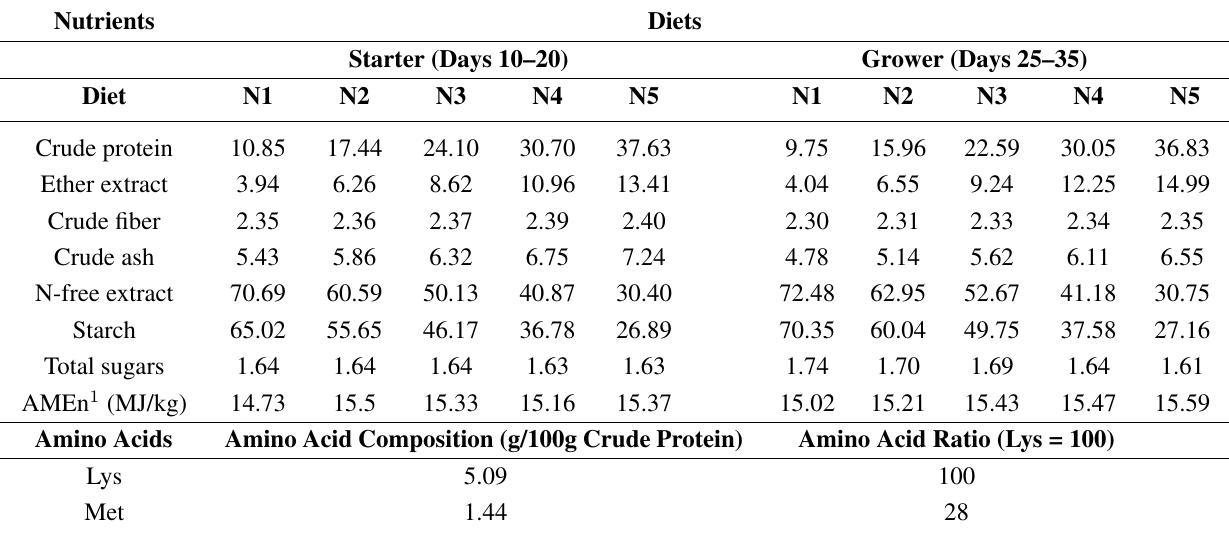
Table 2. Analyzed nutrient content and amino acid composition of experimental diets (percent on dry matter